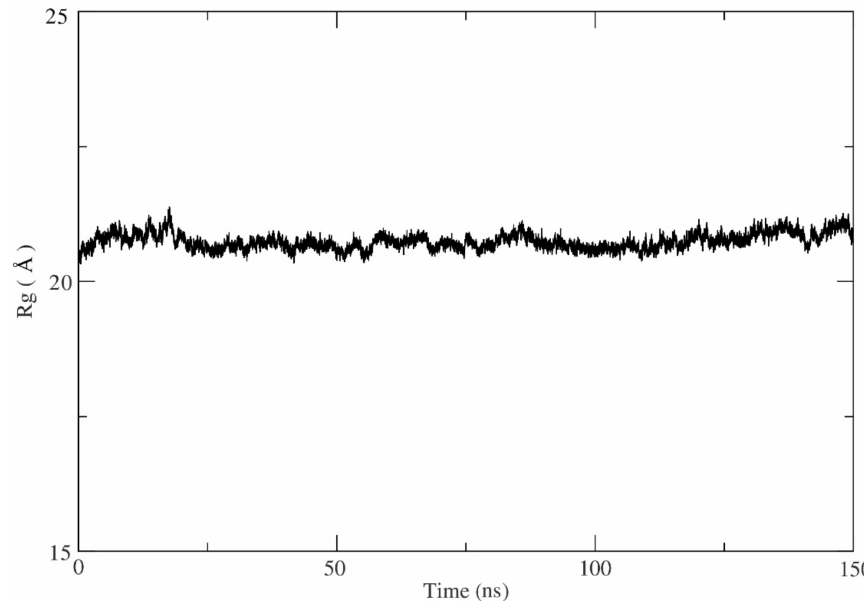
Figure 9. Radius of gyration of protein-ligand complexes.